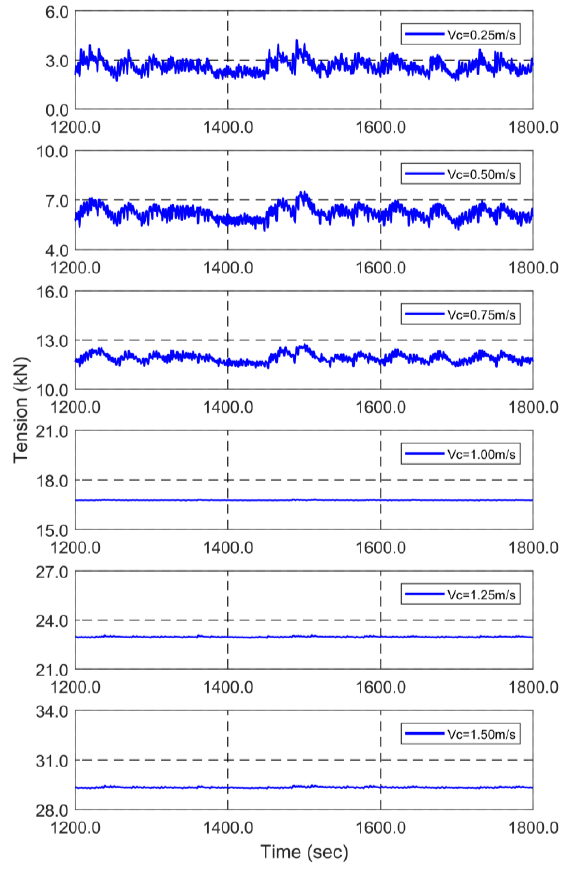
Figure 12. Time histories of mooring tension at different current velocities under identical wave excitations (H s = 1.0 m, T p = 5.25 sec).